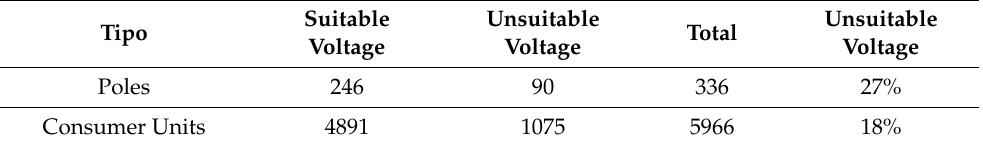
Table 4. Feeder- α report extracted data.